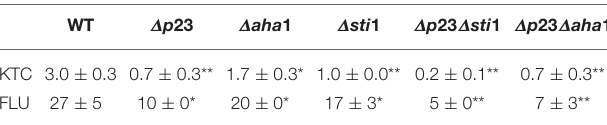
Differences between the mutants and the wild type (WT) were statistically analyzed by the LSDandDunnettT-tests(homoscedastic).Valuesthataresignificantlydifferent(P < 0.01) are marked with ** and values that are different (0.01 < P < 0.05) are marked with *